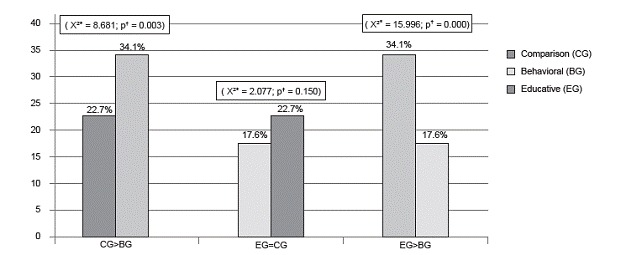
Comparison among percentages of non-attendance to the return appointment. Fortaleza, CE, Brazil, 2011